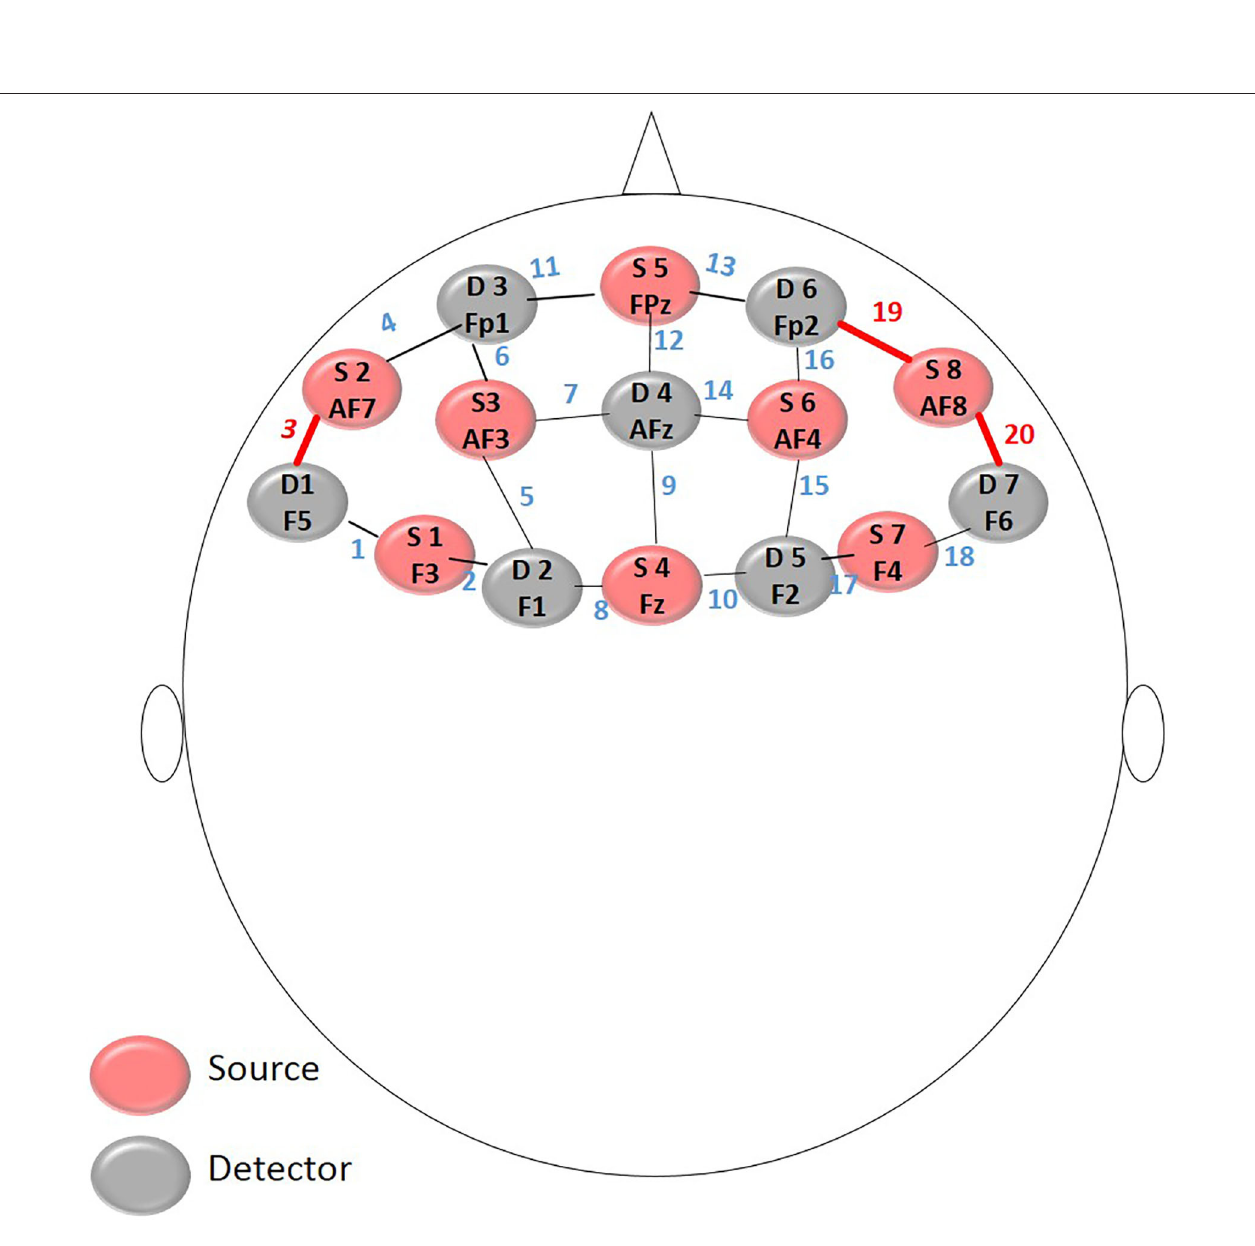
Frontiers in Human Neuroscience |